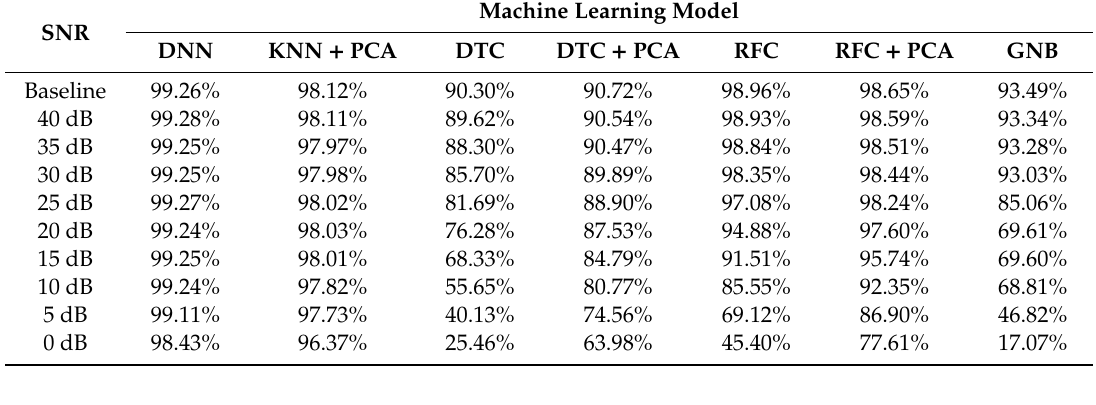
Table 2. Average inference accuracy with simulated thermal noise.